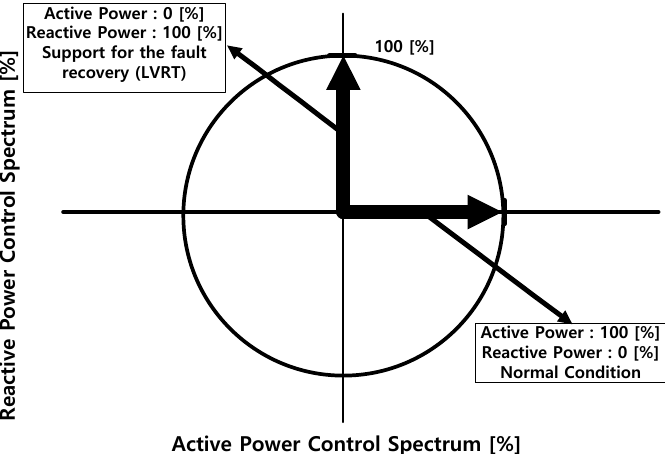
Figure 4. The characteristics of the converter